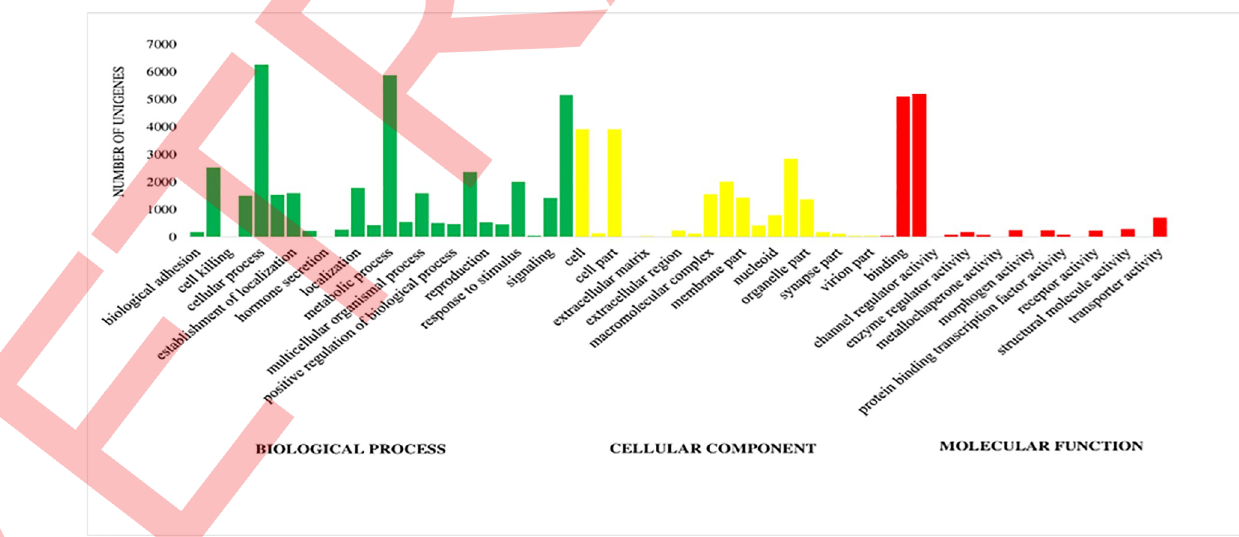
Fig 8. Gene Ontology (GO) classification of identified unigenes from Rhynchophorus ferrugineus fat body tissues transcriptome. Functional classes “biological process,” “cellular components,” and “molecular function” are indicated by green, yellow, and red colors, respectively.